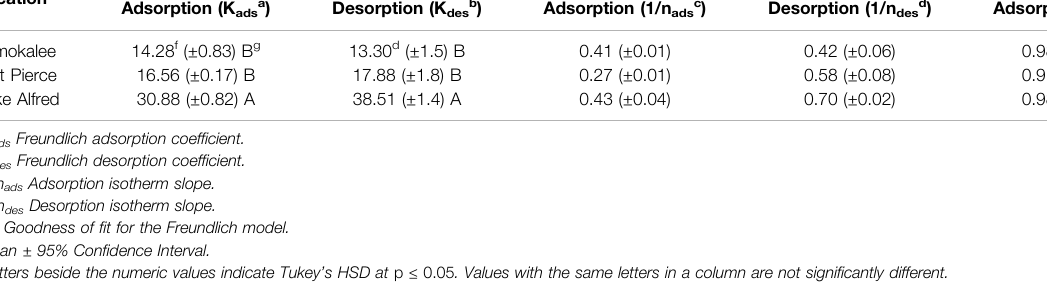
TABLE 2 | Adsorption and desorption (Freundlich model) parameters of glyphosate in Florida ’ s citrus production soils. Soil /